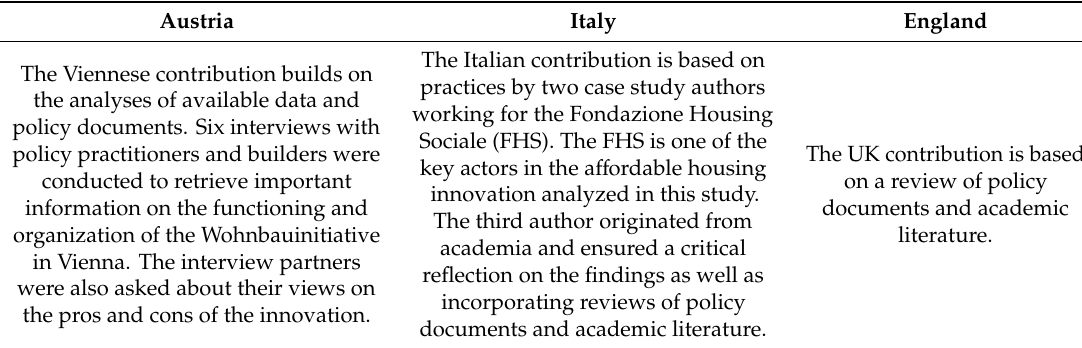
Table 2. Overview of the three case study